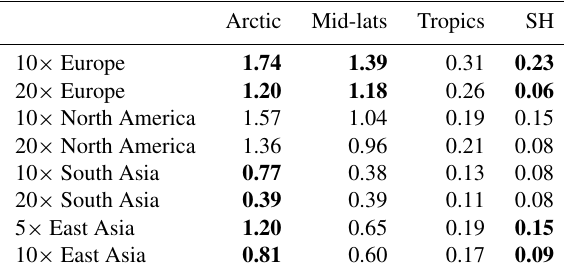
Table 3. Surface temperature change per global direct radiative forcing (in K per Wm − 2 ). Bold numbers represent statistically sig- nificant differences between the emission rates (using 10 vs. 20 or 5 vs. 10 for East